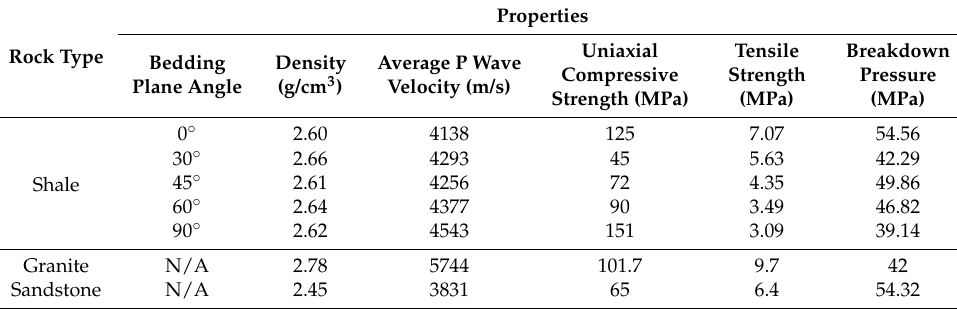
Table 1. Sample characteristics.